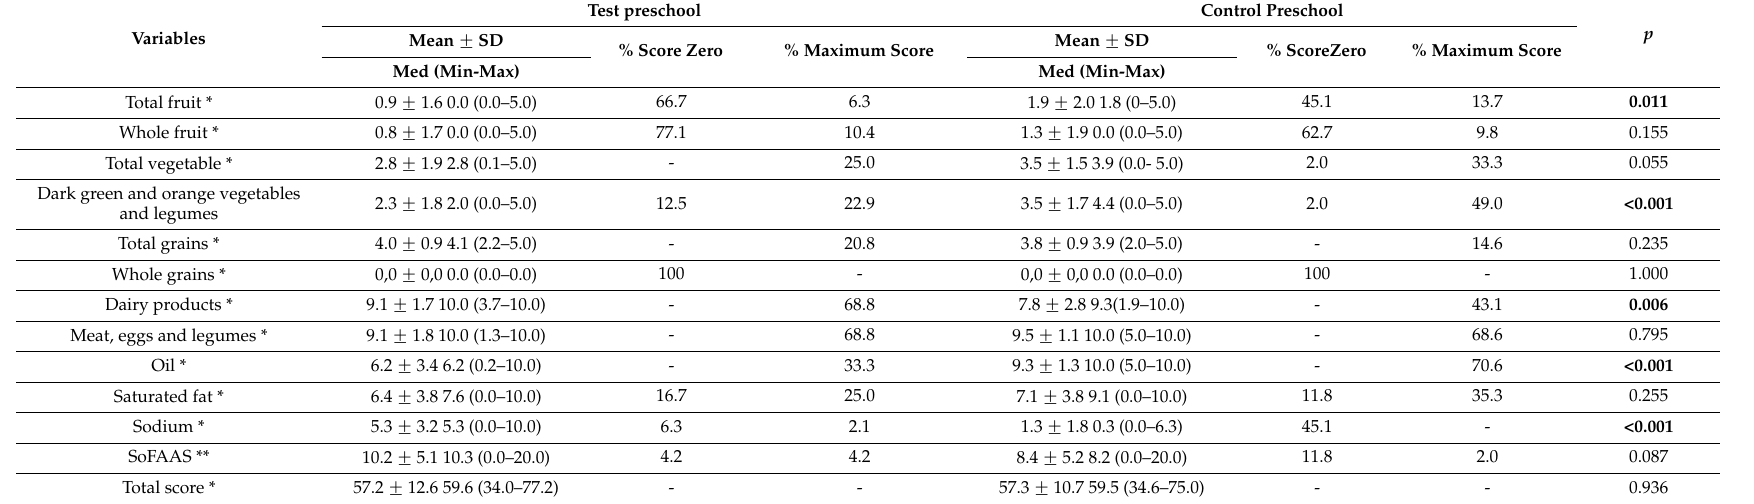
Table 5. Comparison of the total scores and of the components of the Healthy Eating Index in children from two philanthropic preschools.